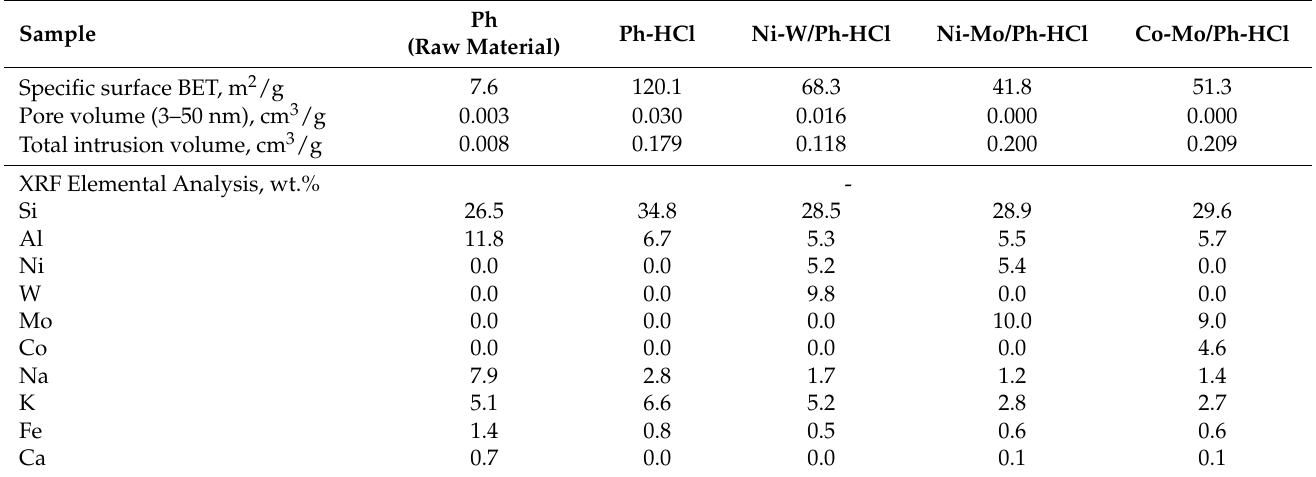
Table 2. Characterization of Ph raw material, Ph-HCl, Co-Mo/Ph-HCl, Ni-MoPh-HCl and